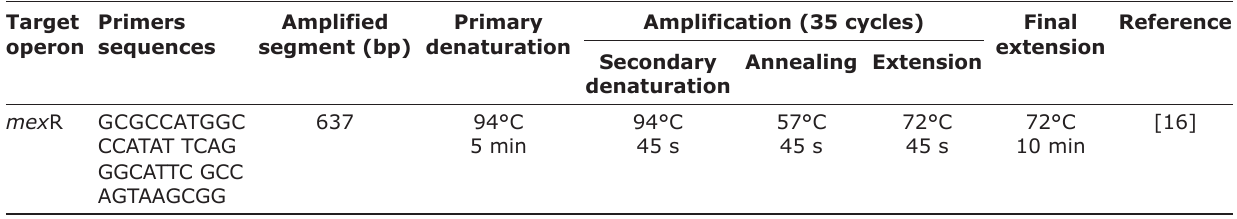
Table-1: Uniplex PCR: Primers sequences, target operons, amplicon sizes, and cycling conditions. Target Primers operon sequences